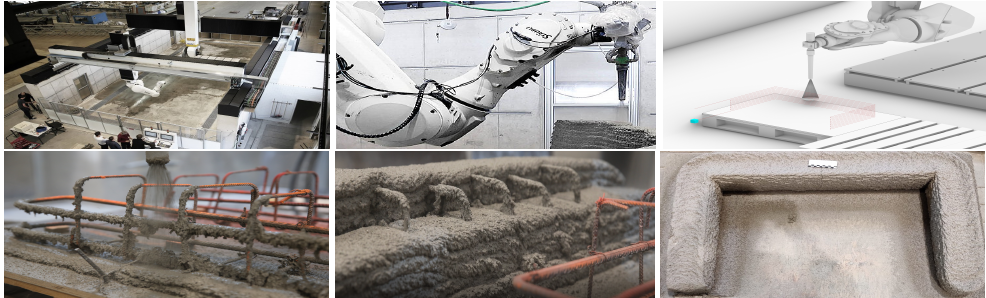
Figure 21. Robotic printing process for construction of the U-shape frame (DBFL, ITE and TU- Braunschweig).